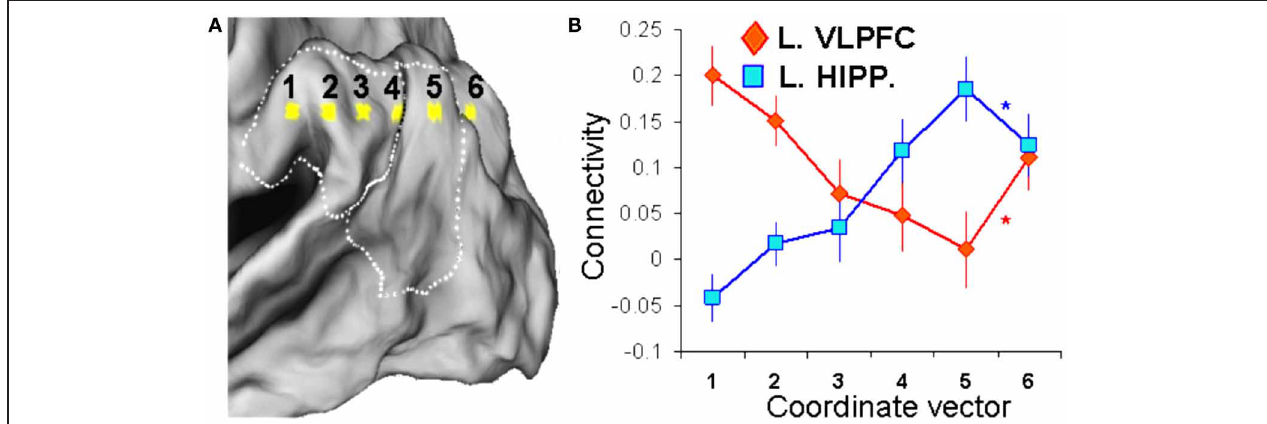
FIGURE 2 | Graded differences between attention-reorienting and recollection seeds. (A) Depiction of a 3D vector consisting of 6 points (6mm apart) traversing through the attention-reorienting and recollection VPC seeds, which was used to investigate the VPC connectivity patterns with VLPFC and hippocampus. (B) Line graphs are depicting VPC connectivity for VLPFC (red line) and hippocampus (blue line) along the 3D vector. Results